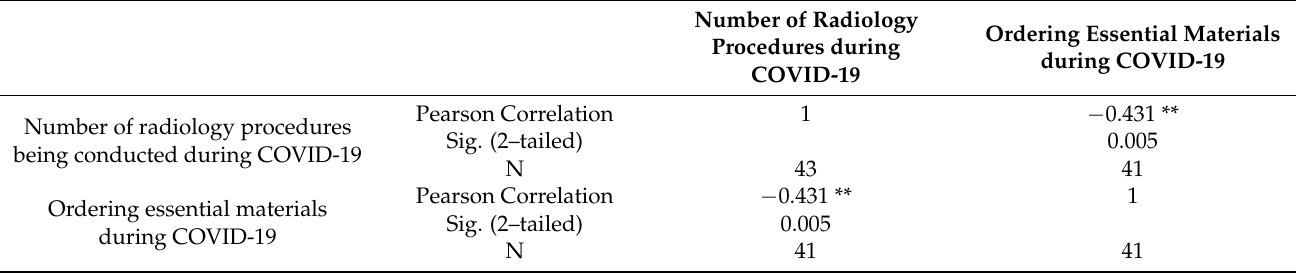
Table 6. Correlation between the number of radiology procedures being conducted due to COVID-19 crisis and changes in ordering of essential materials in radiology departments.